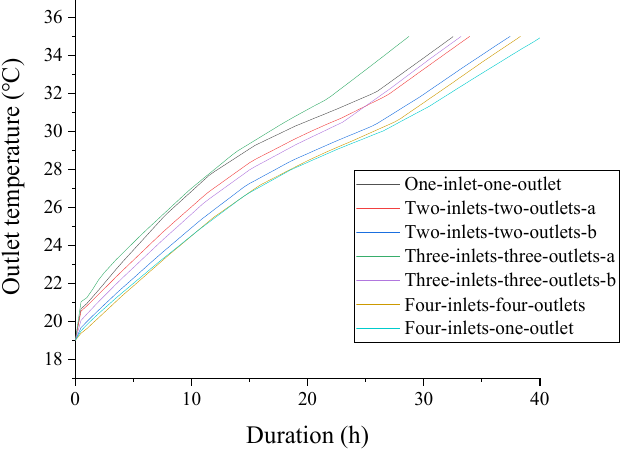
Figure 20. Effect of simulated water distribution on the outlet temperature of the reservoir.